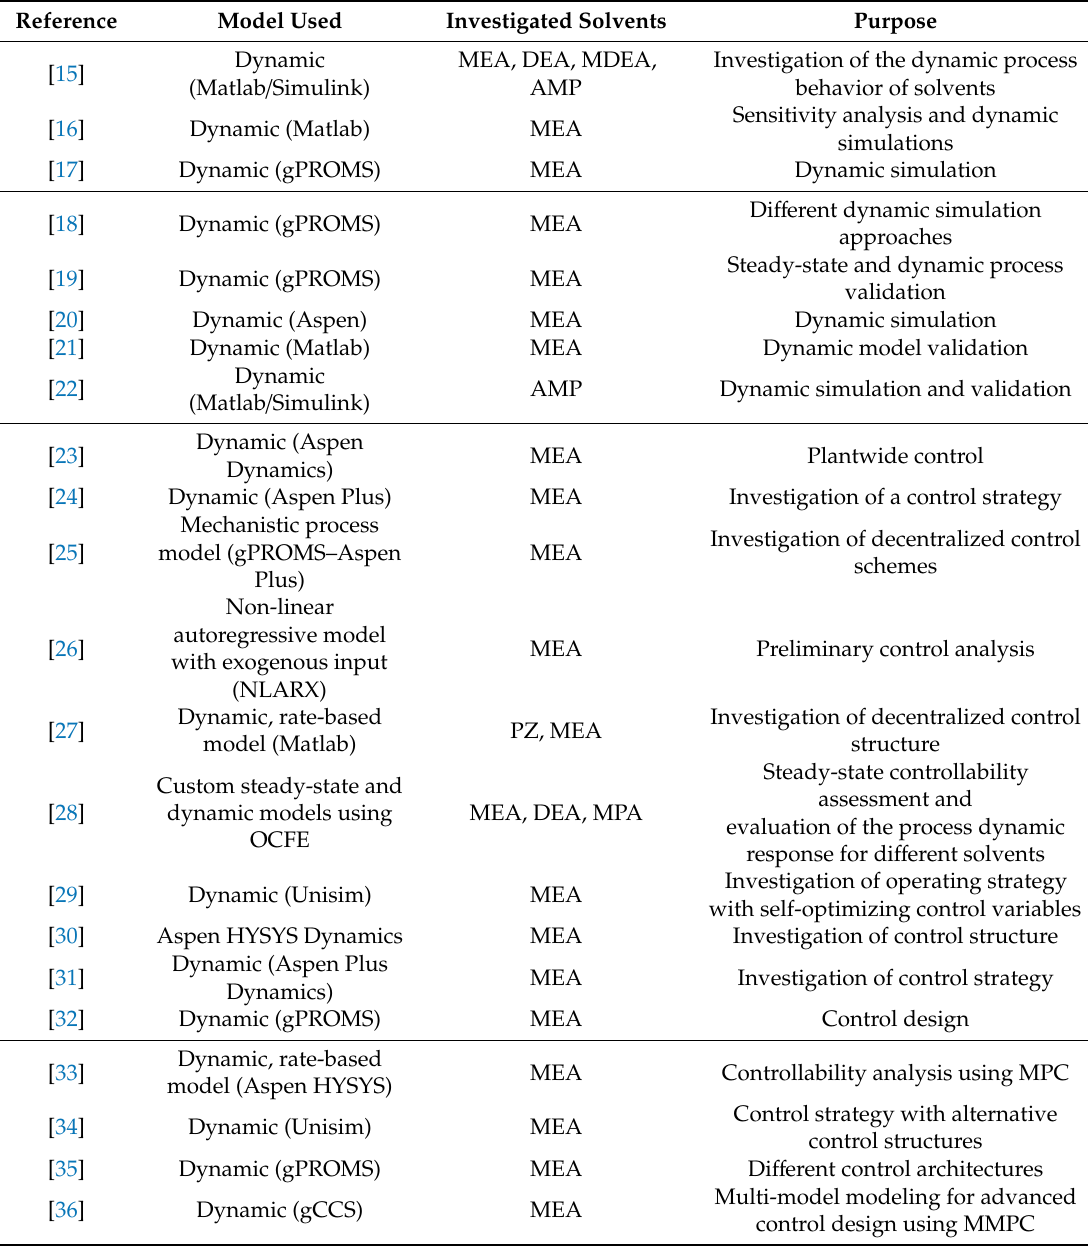
Table 1. Overview of the literature regarding the development of dynamic models, the employed amine solution, and their